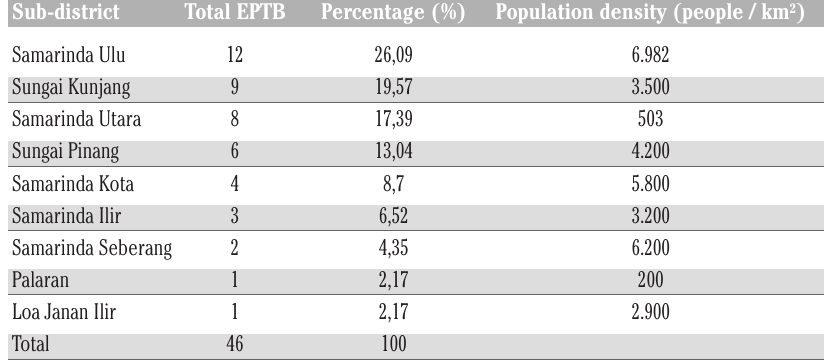
Table 1.General description of EPTB patient in Samarinda City. Table 2. Geographical distribution and distribution pattern of EPTP in Samarinda city.